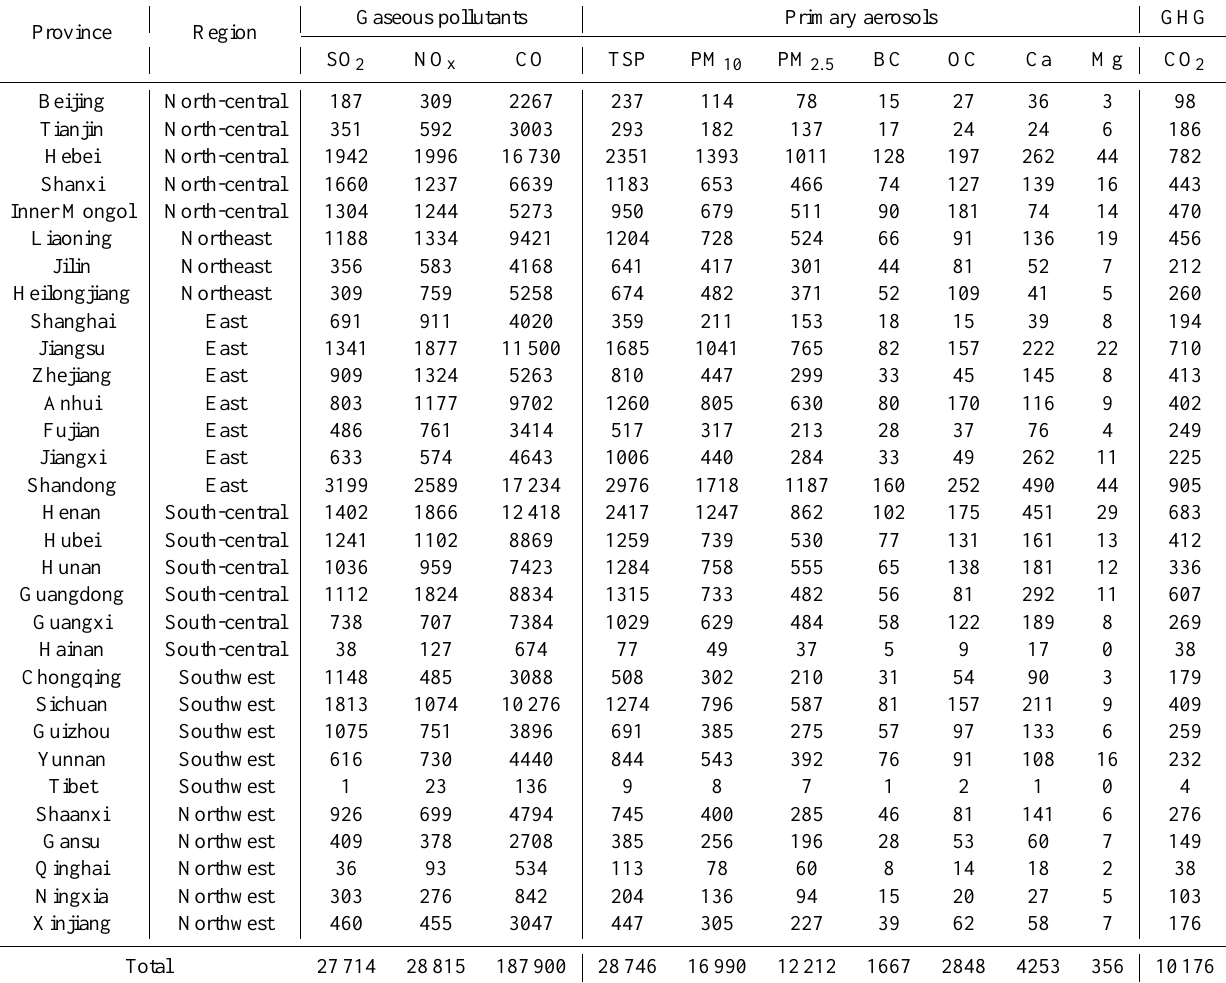
Table 1. Emissions in China 2010 by province (unit: Mt for CO 2 and kilo metric tons (kt) for other species). Gaseous pollutants Primary aerosols GHG Province Region SO 2